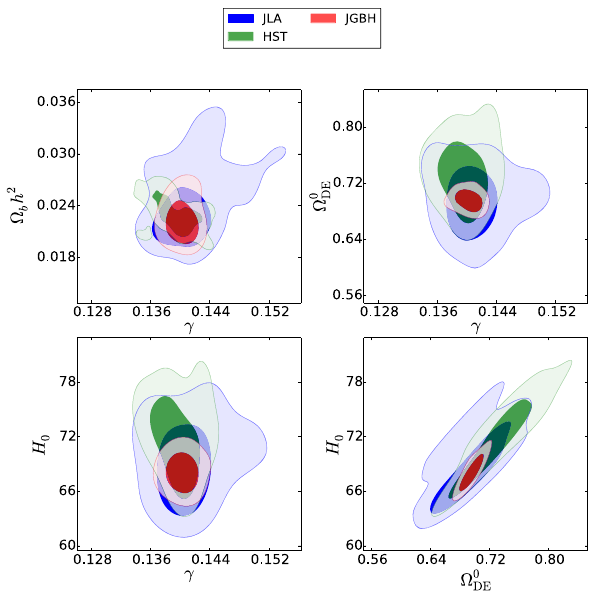
In this figure we find that different observations to confine γ ,